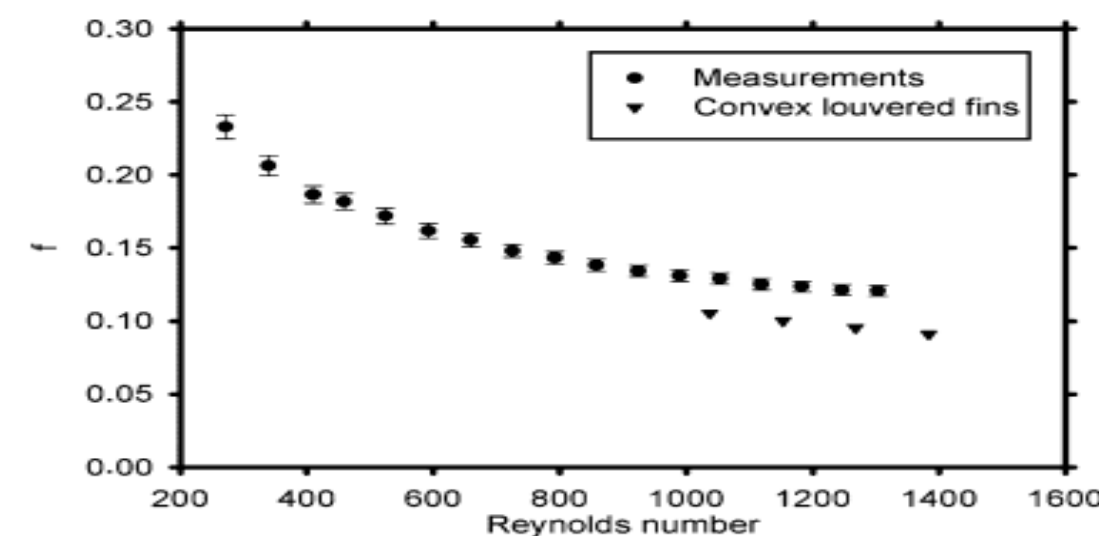
Figure 12: Restrained values of friction factor against air side Reynolds number compared to expected values by the correlation for convex louvered fins (Re>1000)